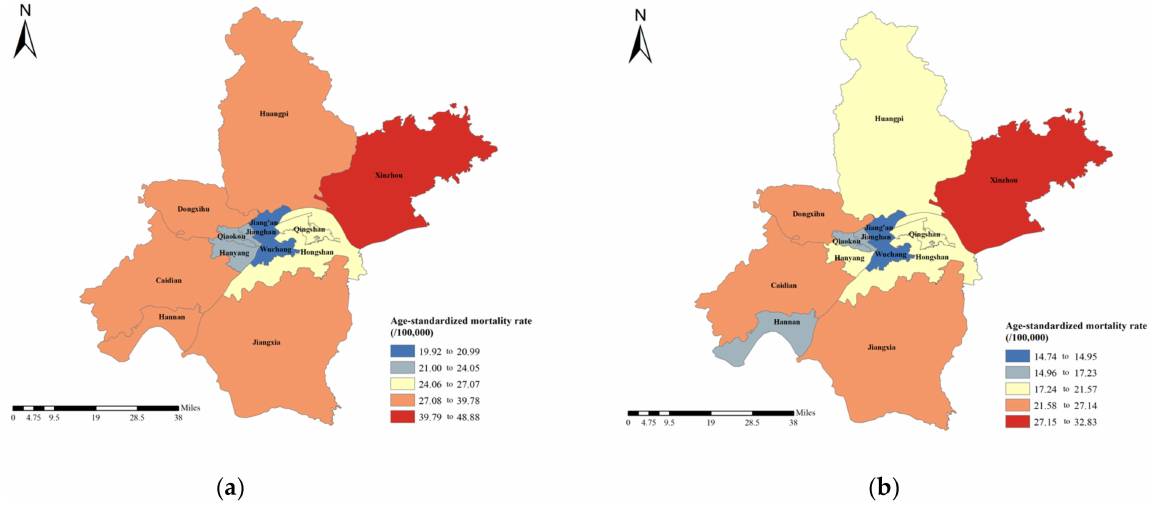
Figure 2. The ASMRs of liver cancer in Wuhan in ( a ) 2010 and ( b ) 2019. As for the ASYR of liver cancer, Wuhan showed an overall trend of steady decline from 2010 to 2019 in Figure 3. In Wuhan, the ASYR of liver cancer was 969.35 per 100,000 people in 2010, and it declined to 581.82 per 100,000 people in 2019, a relative decrease of 39.98%. Similar to the trend in the ASMR, the ASYR of liver cancer also de- creased among men and women. From 2010 to 2019, the ASYR in men decreased from 1507.56 per 100,000 people to 923.01 per 100,000 people, a relative decrease of 38.77%. The ASYR decreased from 430.50 per 100,000 people in 2010 to 243.48 per 100,000 people in 2019 in women, a relative decrease of 43.44% from 2010 to 2019. Meanwhile, it was observed that the ASYR of liver cancer in men was higher than that of women from 2010 to 2019, indicating that the burden of liver cancer in men was severe.